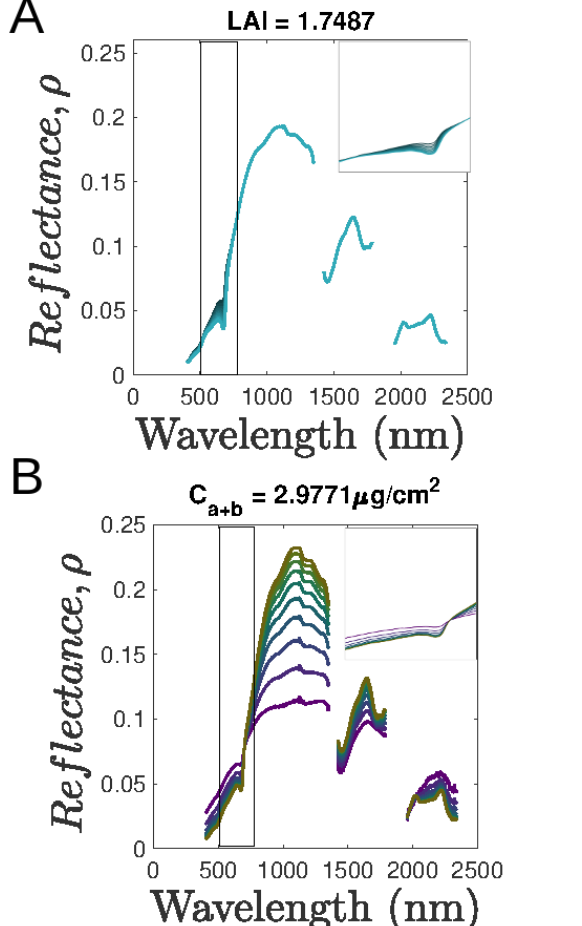
Figure 5. Sensitivity analysis. Variation in the simulated reflectances when C a + b (A) and LAI (B) are varied. Inset shows the reflectances between 500nm and